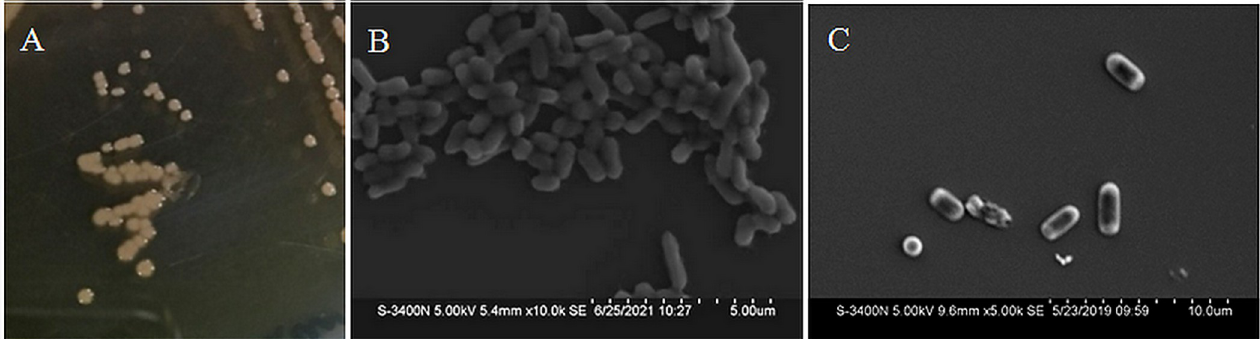
Fig 1. Colonies morphology and scanning electron microscope (SEM) analysis of the endophytic P . aeruginosa strain Ld-08, isolated from L . davidii . (A) Colony morphology of Ld-08 on LB agar plates. (B,C) SEM image showing rods-shaped structures.